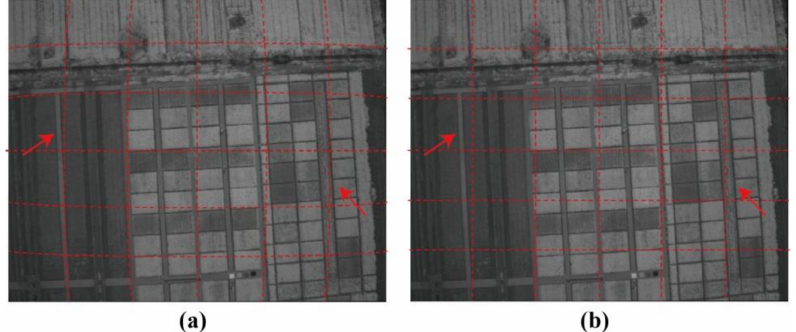
Figure 8. A comparison of the MCA-4 images ( a ) before and ( b ) after lens distortion correction at the booting